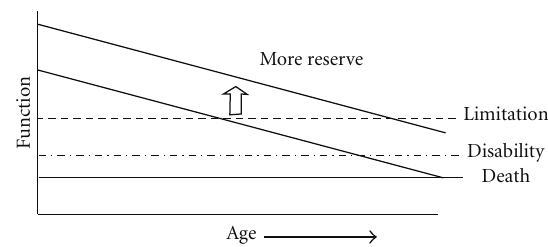
Figure 10: Hypothesized relationship between physiologic aging, functional health and chronological age